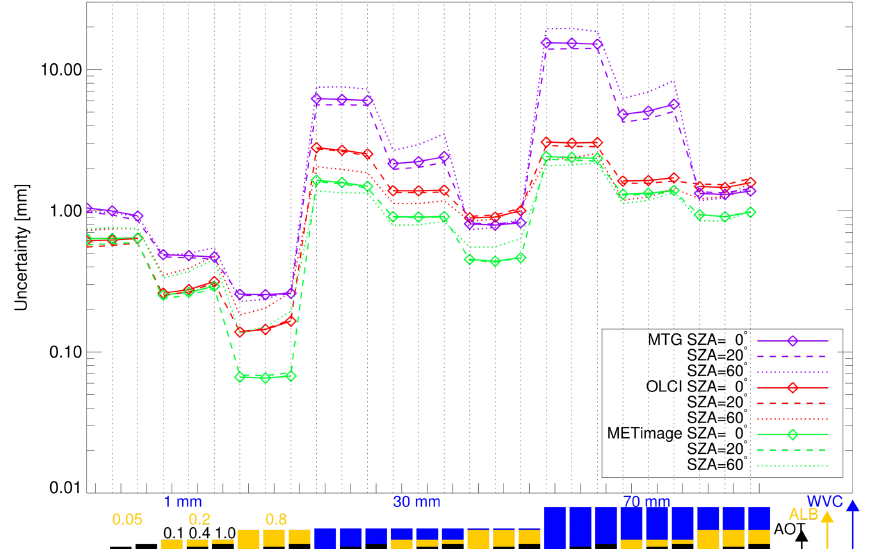
Fig. 5. Uncertainties of water vapour retrievals in mm of three channel combinations of future instruments (OLCI, METimage, MTG) for 27 different cases of a combination of three atmospheric properties: total column water vapour (TCWV), albedo (ALB), and aerosol optical thickness (AOT); for three different sun zenith angles (SZA).